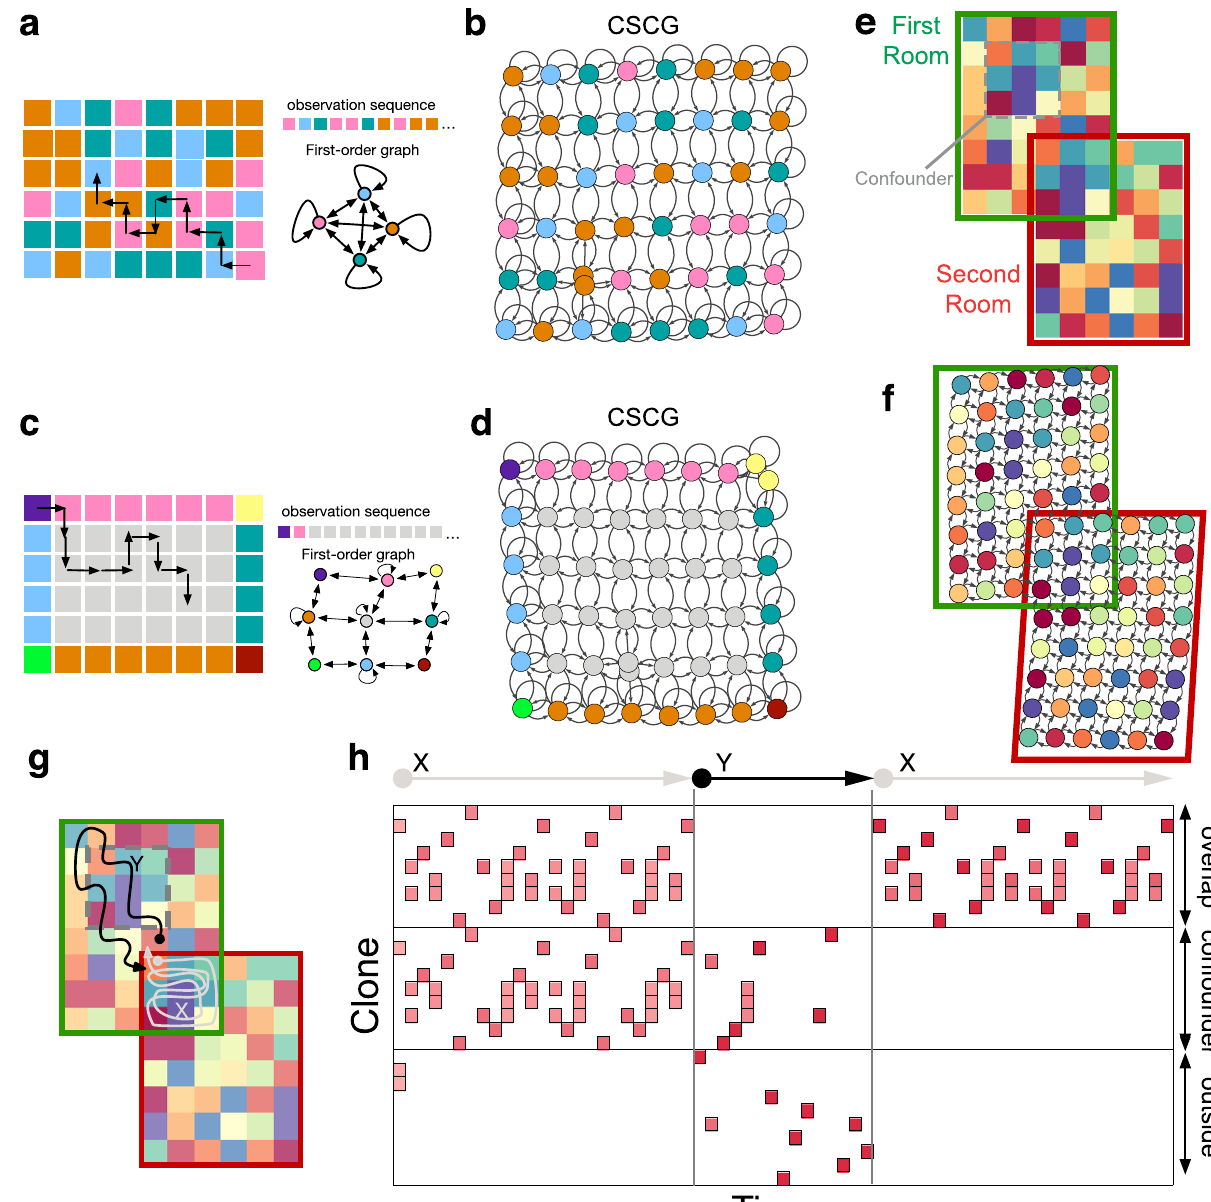
Fig. 2 Spatial representations emerge from aliased sequential random walk observations without Euclidean assumptions. a A random walk in a room with only four unique observations (colors) will produce a severely aliased sequence as re fl ected in the fi rst-order Markov chain. b In contrast, transition graph learned by CSCG on random walks in a recovers the spatial layout. Nodes in this graph are the clones, and the observation they connect to are indicated by the color of the node. c Room with a uniform interior produces aliased sequences highly correlated in time. d Transition graph learned by CSCG on random walks in c , represented similar to b . The redundant yellow nodes (and some brown nodes in b ) are due to slight imperfections in learning, but do not affect the representation or behavior. e An agent experiences two different, but overlapping rooms in disjoint sequential episodes. The overlap region also repeats in the fi rst room, acting as a confounder. f As re fl ected in the transition graph, CSCG performs transitive inference to stitch together the disjoint experience into a coherent global map, and correctly positions the confounder. g , h Activation of clones over time as the agent takes the trajectories X (gray), Y (black), and X again in the maze in g . Each red square is a clone activation in one time step. During the fi rst traversal of X , the clones corresponding to the overlap and the confounding patch are active because the agent started within the overlap and stayed within. Stepping outside the overlap immediately resolves ambiguity, which is re fl ected in the clone activity during the traversal Y which includes confounder region and areas outside overlap and confounder, and also during the second traversal of X . See also Supplementary Video